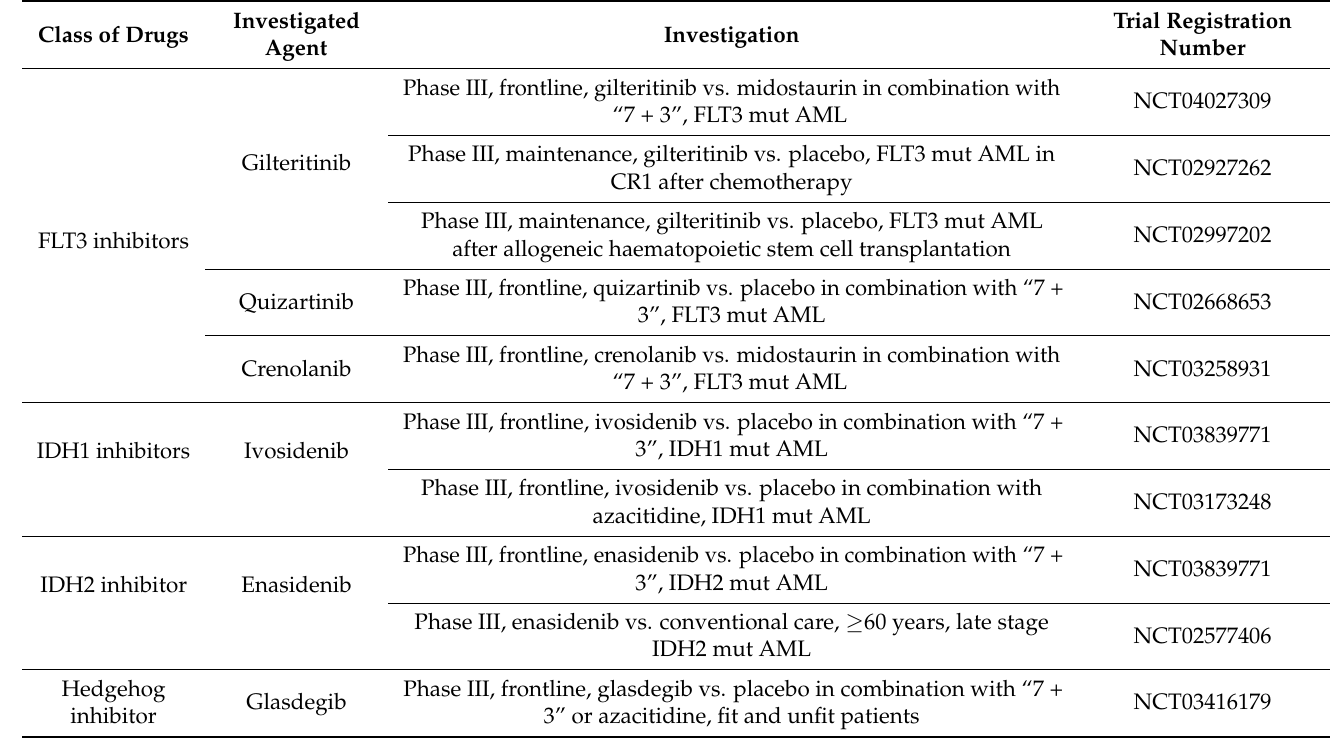
Table 1. Randomized clinical trials for drug development in